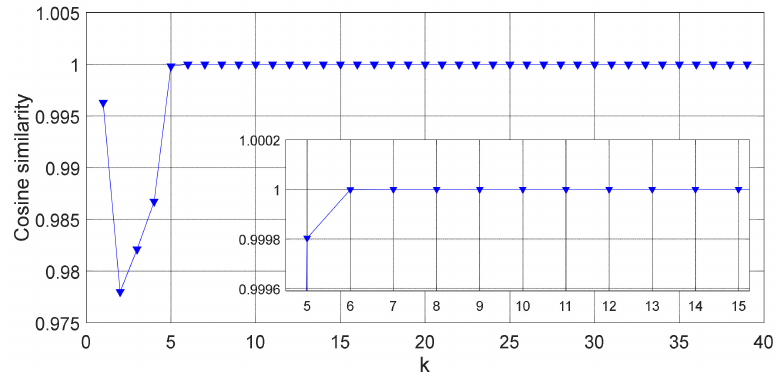
Figure 4. Cosine similarity of adjacent constructing components.